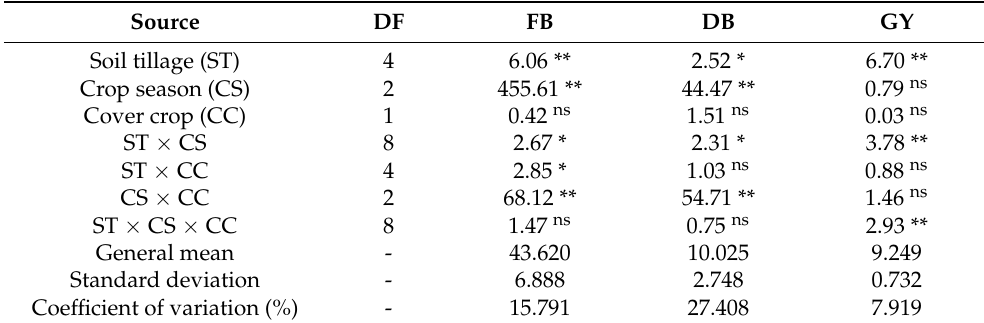
Table 1. Analysis of variance ( F test) of the triple factorial (soil tillage treatment, crop season, cover crop) for fresh above-ground biomass (FB) and dry above-ground biomass (DB) of the cover crop at the end of the crop cycle, and maize grain yield (GY).